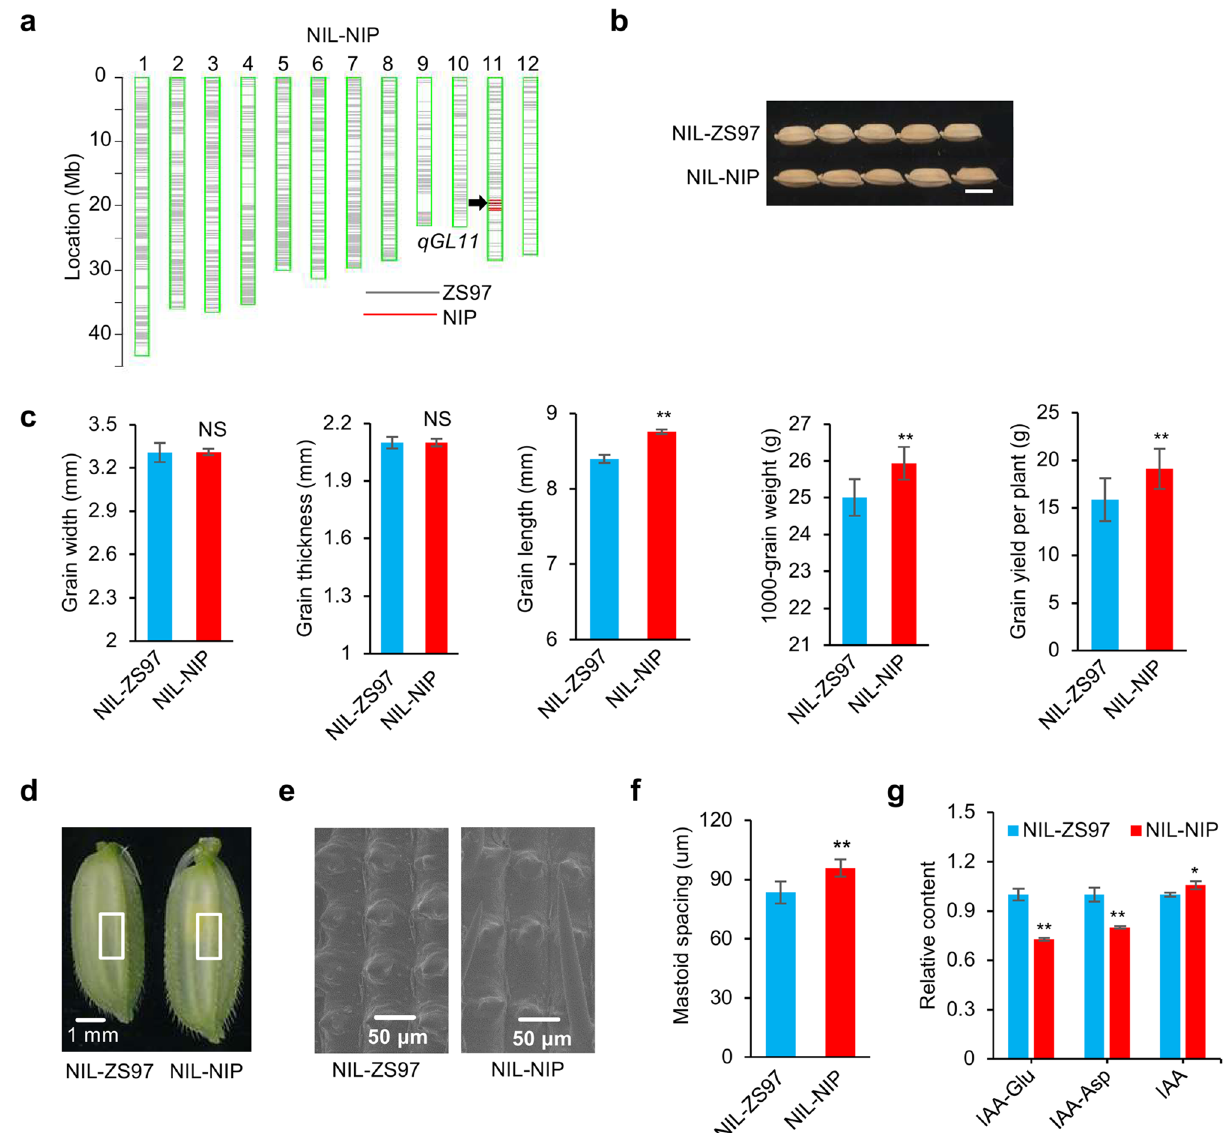
Figure 3. Differences between NIL-ZS97 and NIL-NIP with the contrasting alleles at qGL11. ( a ) Graphic genotype representation of NIL-NIP. ( b ) Differences between NIL-ZS97 and NIL-NIP in seed morphology. Scale bar: 5 mm. ( c ) Comparison of the grain size and grain yield in NIL-ZS97 and NIL-NIP. Data are given as the mean and SE ( n = 10). ( d – f ) Scanning electron microscopy analysis of the lemma. Differences between NIL-ZS97 and NIL-NIP in spikelet morphology ( d ), cell morphology ( e ), longitudinal cell length ( f ) in the lemmas of spikelet hulls. Values provided as the mean and SE ( n = 10). ( g ) IAA and IAA-amino acid conjugate species in NIL-ZS97 and NIL-NIP. Content relative to NIL-ZS97, which was set to 1, is presented as the mean and SE of triplicates. **, * indicate a significant difference at P < 0.01 and P < 0.05, respectively, by Student’s t -test . NS, no variation among rice varieties. In its promoter region (3-kb upstream of the predicted start codon), 14 SNPs and three Indels were found between ZS97 and NIP. In particular, the A/G variant at the -2458 site upstream of the start codon may cause auxin-response element (GAT ACA ) defects in OsGH3.13 NIP (Fig. 2f). In the coding region, there were three nonsynonymous SNPs resulting in amino acid changes (Supplementary Table S7). Thus, OsGH3.13 is a possible candidate gene for qGL11 . Validation of the qGL11 effect in NILs. To confirm the qGL11 effect, NIL-NIP and NIL-ZS97 were evaluated in grain size and other yield-related traits (Fig. 3a). Phenotypic comparison of NILs showed that the average grain length of NIL-NIP was 4.3% longer than that of NIL-ZS97, and the thousand-grain weight was 3.7% greater than that of NIL-ZS97, while grain width and grain thickness was not significantly different between NILs (Fig. 3b,c). Notably, the grain yield of NIL-NIP was increased by approximately 20% compared to